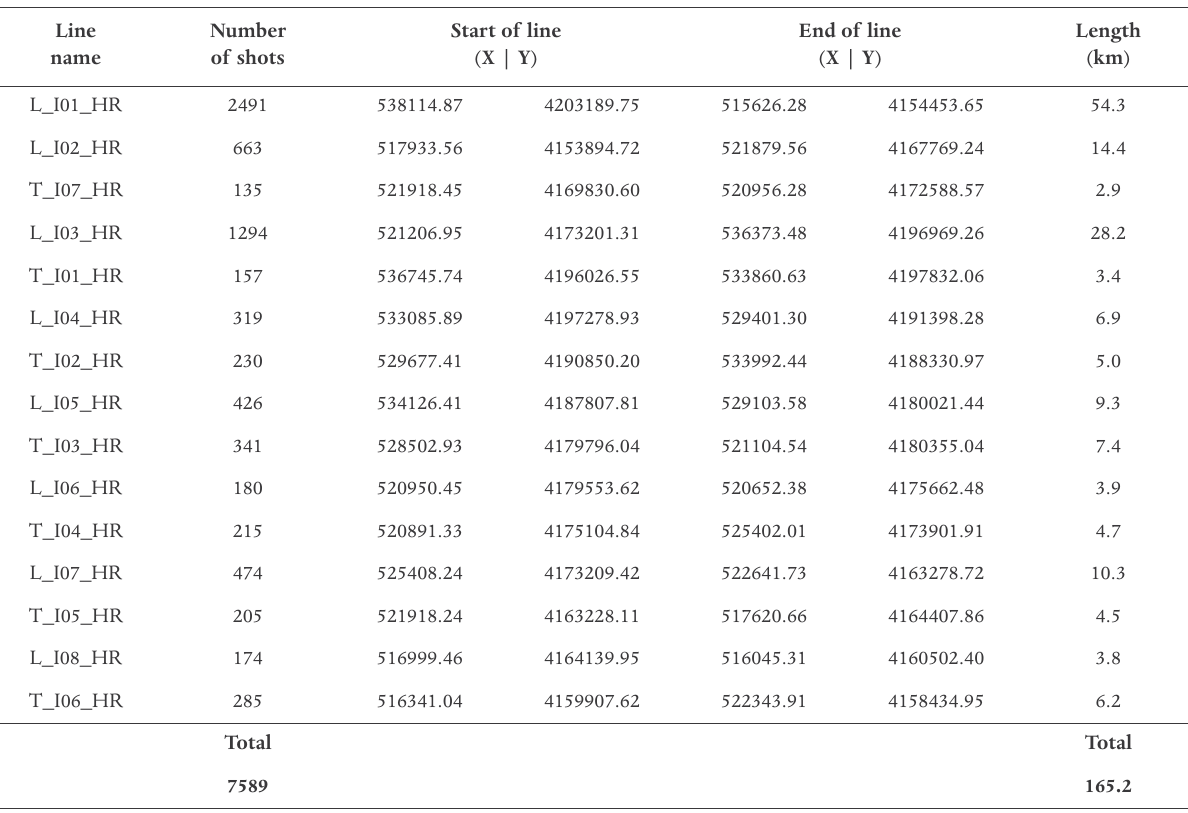
Table 3. Main characteristics of MCS lines acquired in the Ionian Sea area, during the TOMO-ETNA oceanographic cruise with the R/V “Aegaeo”. The coordinate are projected in UTM-WGS84, zone